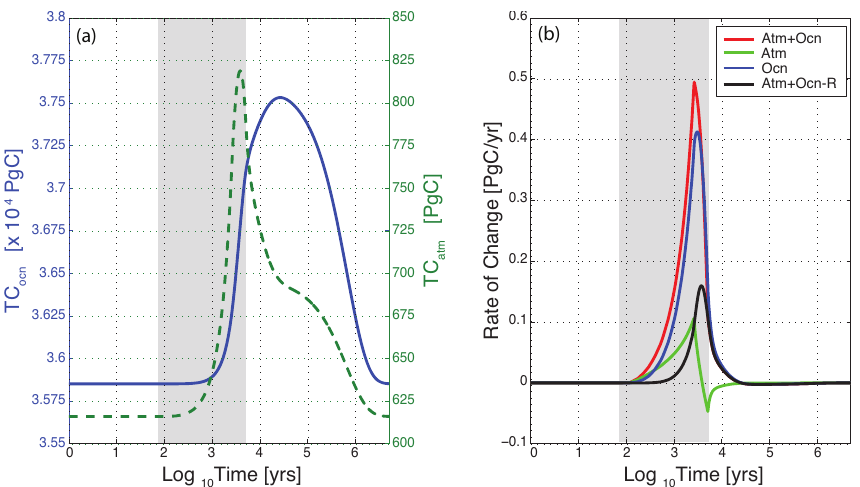
Figure 2. System response as a function of time for the case of E = 1000PgC and D = 5kyr. Shaded regions indicate time of emission. (a) Total carbon in the atmospheric (green dashed line) and oceanic (blue solid line) reservoirs. (b) Corresponding rates of change. System total is shown in red, ocean in blue, atmosphere in green, and the fluxes resulting from feedbacks in the carbon system to the applied emission R in black.